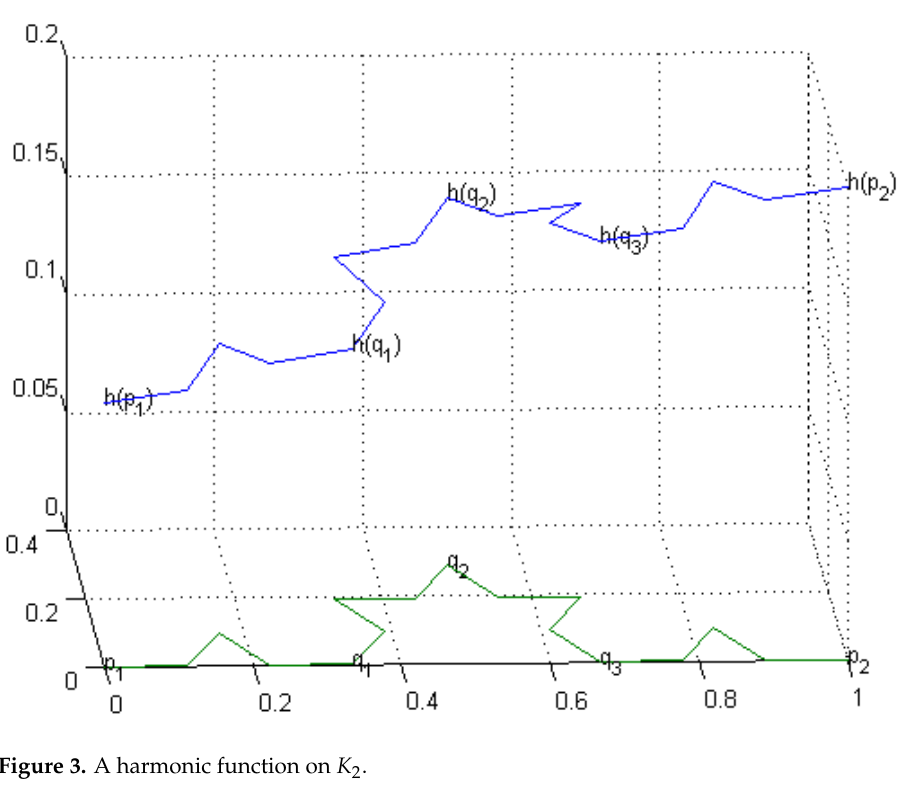
Figure 3. A harmonic function on K 2 .